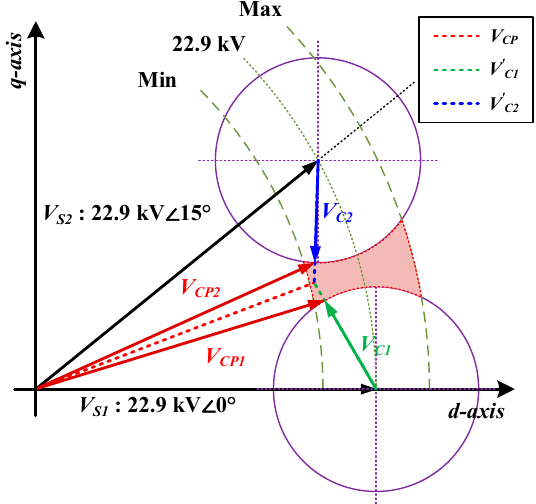
Figure 8. Vector diagram of the distribution line when the maximum output voltage of the APC is exceeded (when the phase of V S1 is 0°).